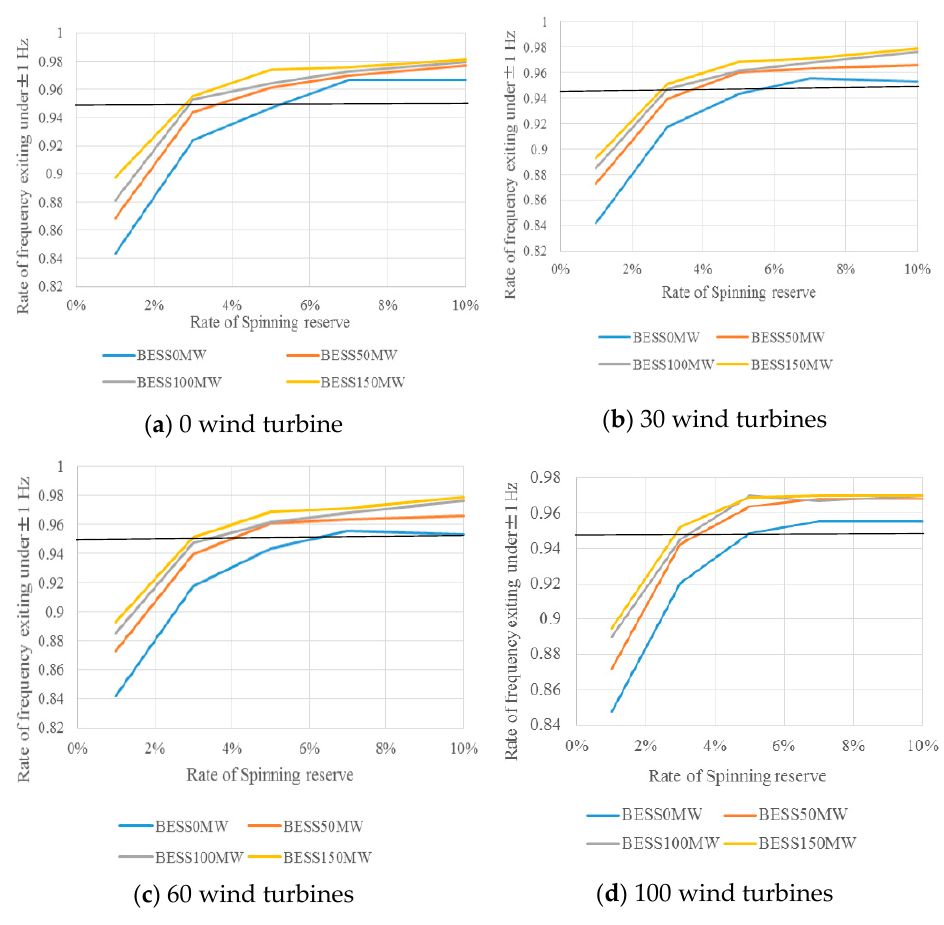
Figure 10. Rate of frequency under ±1 of 5.7 m/s wind turbine.